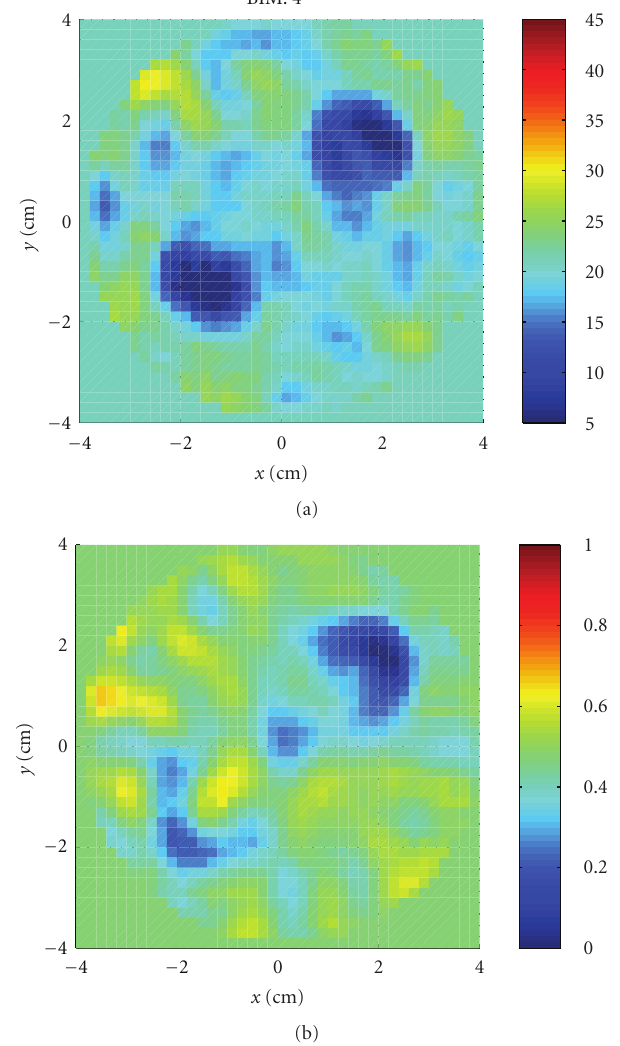
Figure 21: Reconstructions of the two acrylic spheres of Experiment 1 shown in Figure 19(b). (a) Relative permittivity. (b) Conductivity. The permittivity is again recovered well but the shape in the conductivity is not.